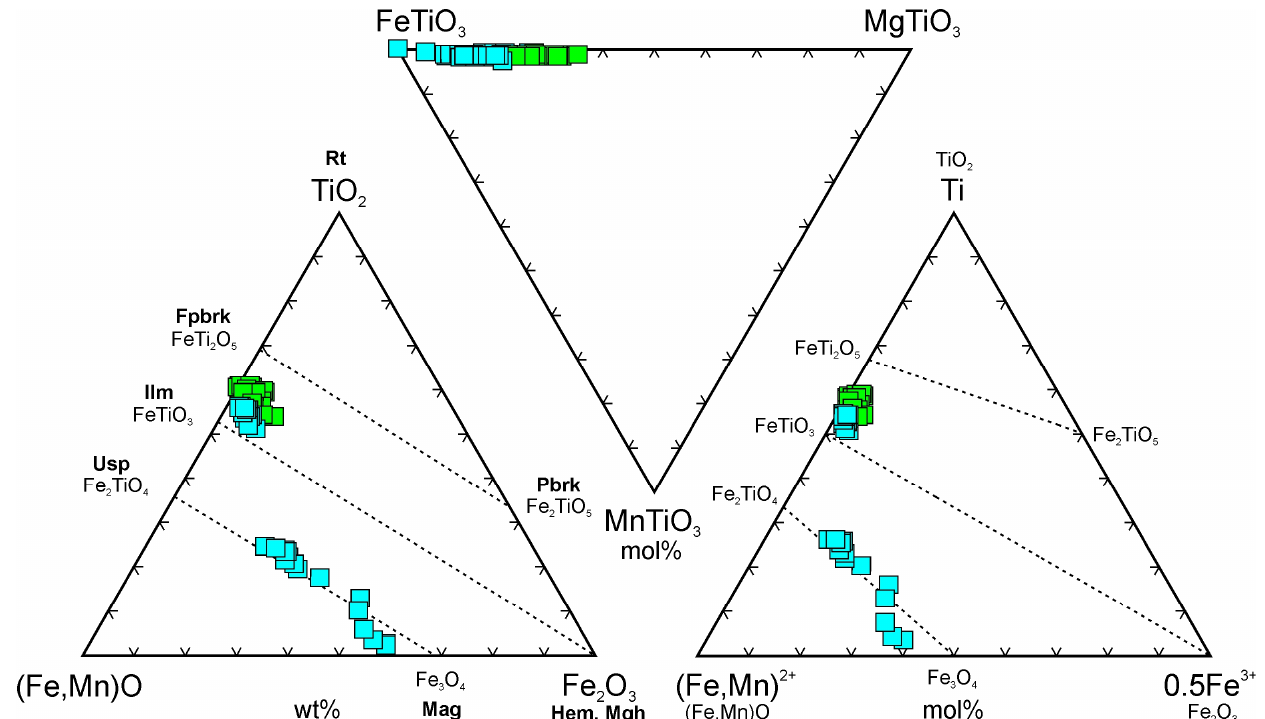
Figure 15. General classification schemes of oxyspinels and ilmenite [43] with projection points of ilmenite and ulvöspinel ‐ magnetite from Č amovce xenoliths. Green symbols—ilmenites associated with olivine in carbonates, blue symbols—basalt phenocrystic and xenolith interstitial alkalic metasomatic assemblages.